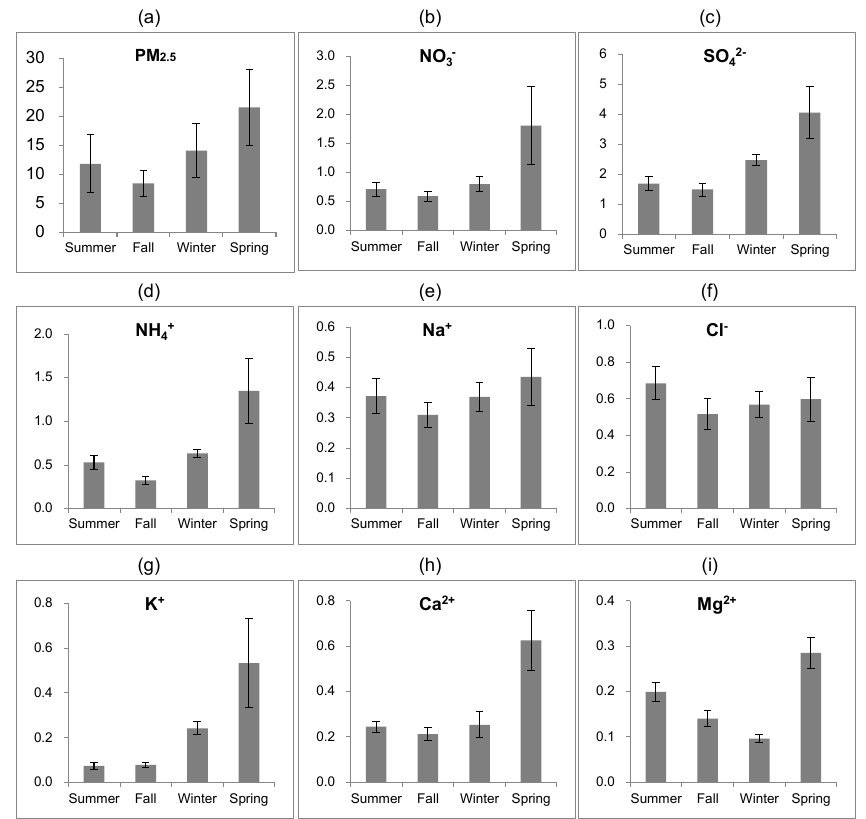
Figure 7. Seasonal mean mass concentration and standard deviation of (a) PM 2 . 5 and its ionic components, (b) NO − (e) Na + , (f) Cl − , (g) K + , (h) Ca 2 + and (i) Mg 2 + (unit in µgm − 3